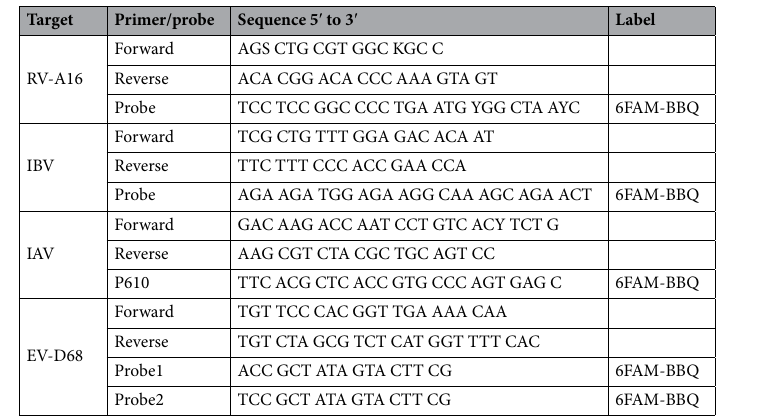
Table 2. Sequences of primers and probes used to detect viral RNA